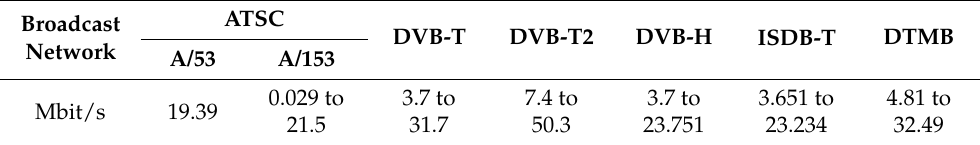
Table 1. Capacity of broadcast network at 6 Mhz (Mbit/s)